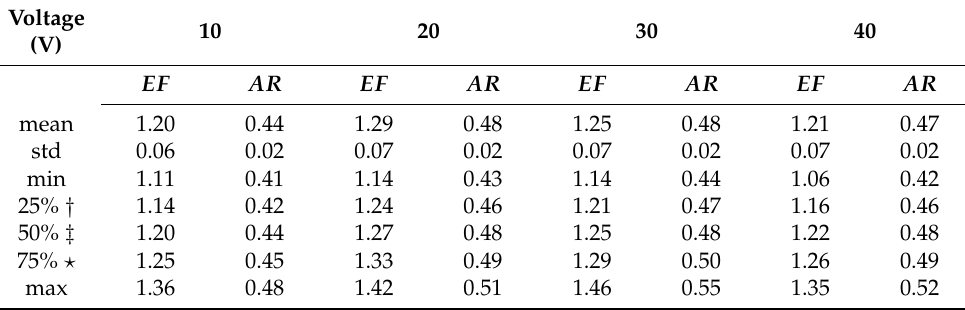
Table 5. EF and AR value of machined cavities with different applied